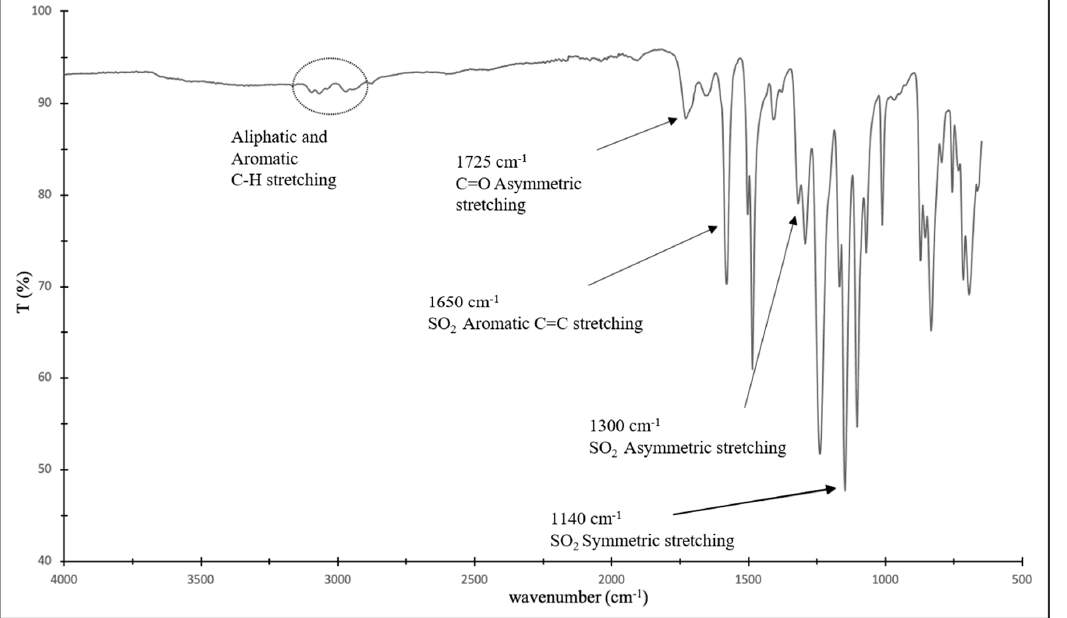
Figure 1. FTIR spectrum of the P(ESES-co-ESDPA) 30:70 copolymer.